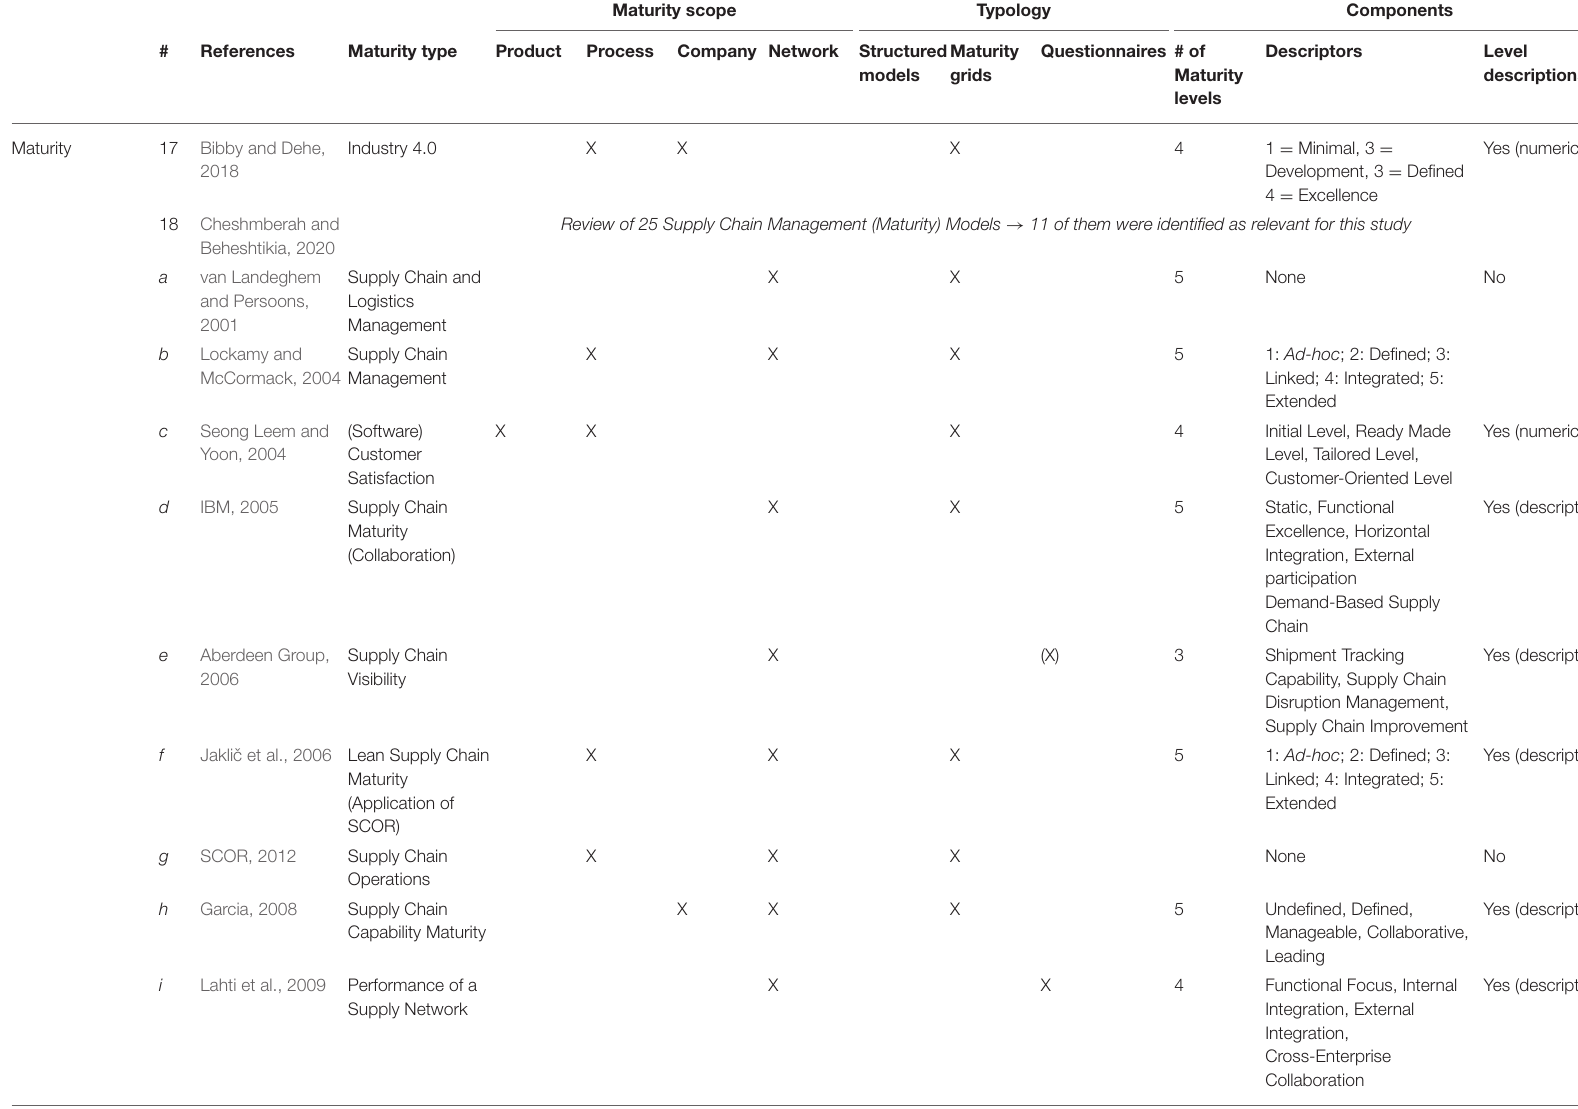
TABLE 3 | Subset maturity